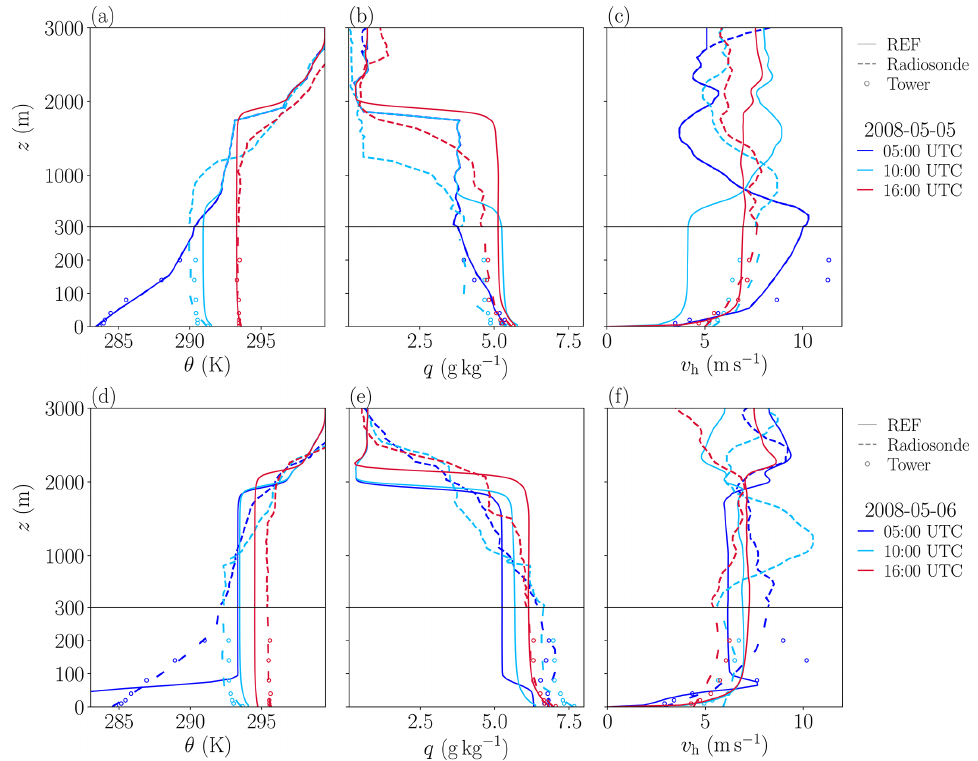
Figure 2. Vertical profiles of θ , q , and v h measured by radiosonde (dashed lines) and the tower (point markers) at the CESAR site as well as simulated profiles of case REF (continuous lines) during the 2d period. Note that the lower 300m is shown with a higher vertical resolution than the layers above to better visualize individual tower measurements (the black horizontal line indicates the